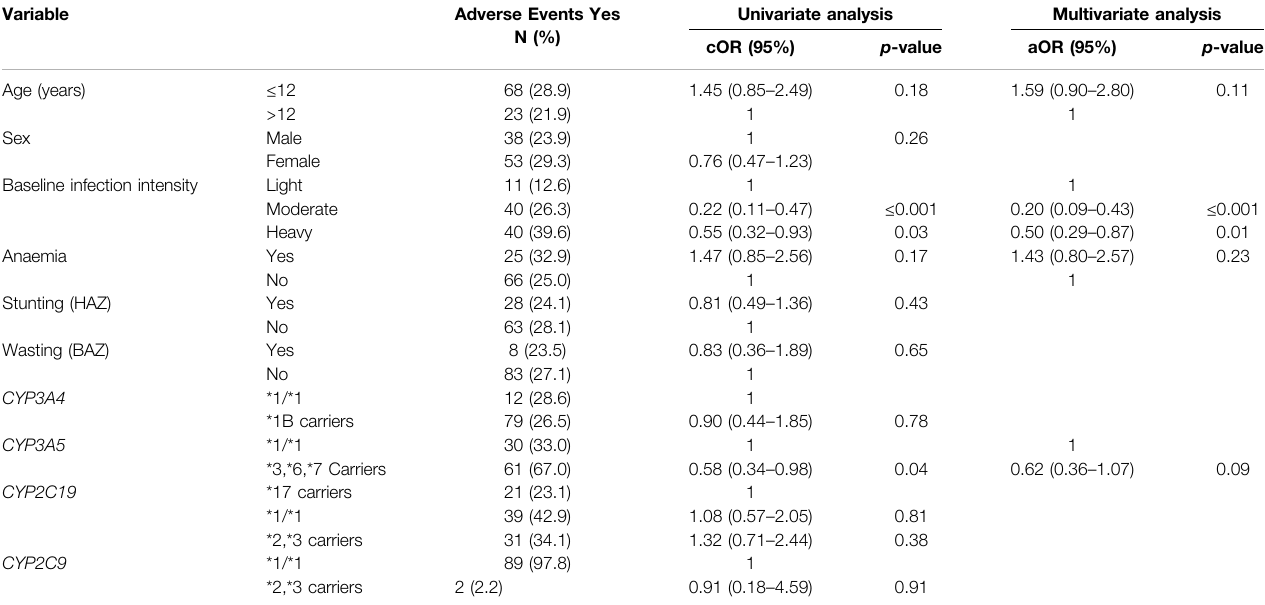
TABLE 6 | Univariate and Multivariate logistic regression analysis for predictors of adverse events.